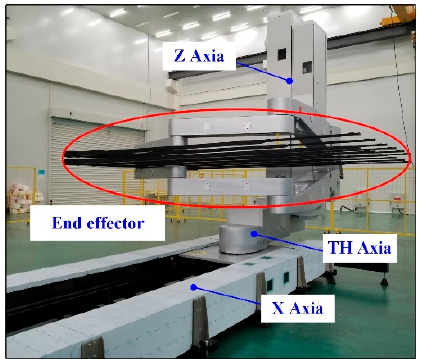
Figure 1. The construction of the glass substrate handling robot.